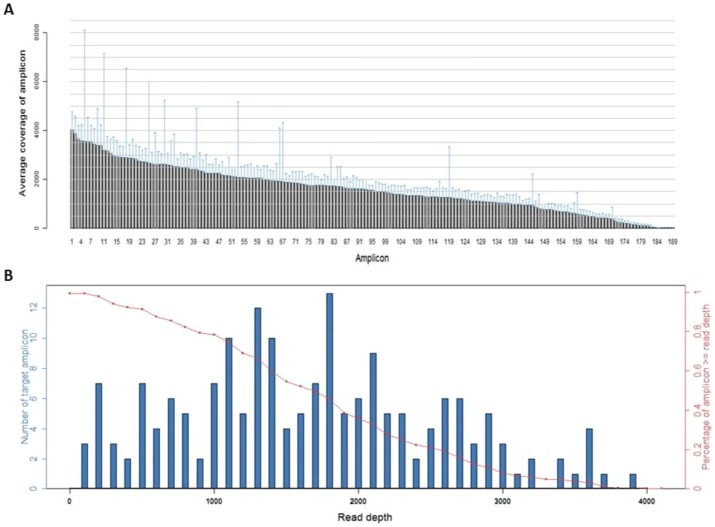
Sequence read distribution across 189 amplicons generated from 238 FFPE specimens, normalized to 300,000 reads per sample.A. Distribution of average coverage of each amplicon. Data are shown as mean ± SD. B. Number of amplicons with a given read depth, sorted in bins of 100 reads. Blue bars represent number of target amplicons within read depth, red line presents % of target amplicons ≥ read depth.